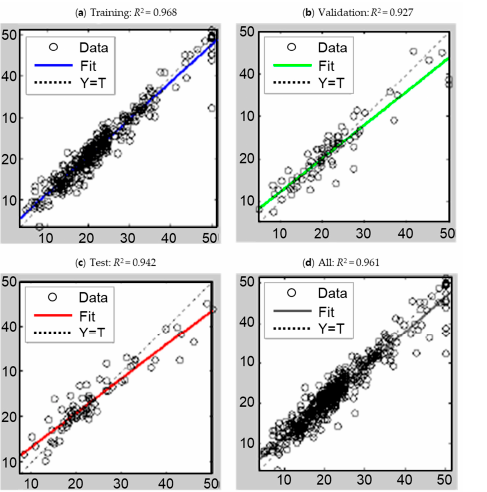
Figure 2. Regression results of an optimized DNN model for: ( a ) training; ( b ) validation; ( c ) test; and ( d ) all datasets.